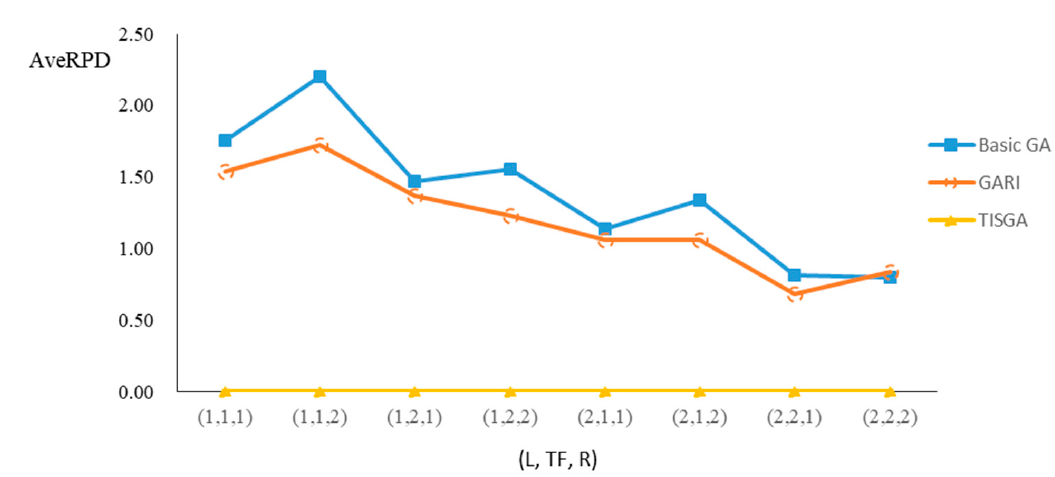
Figure 17. Comparison results for n = 80 with eight combinations of (L, TF, R).